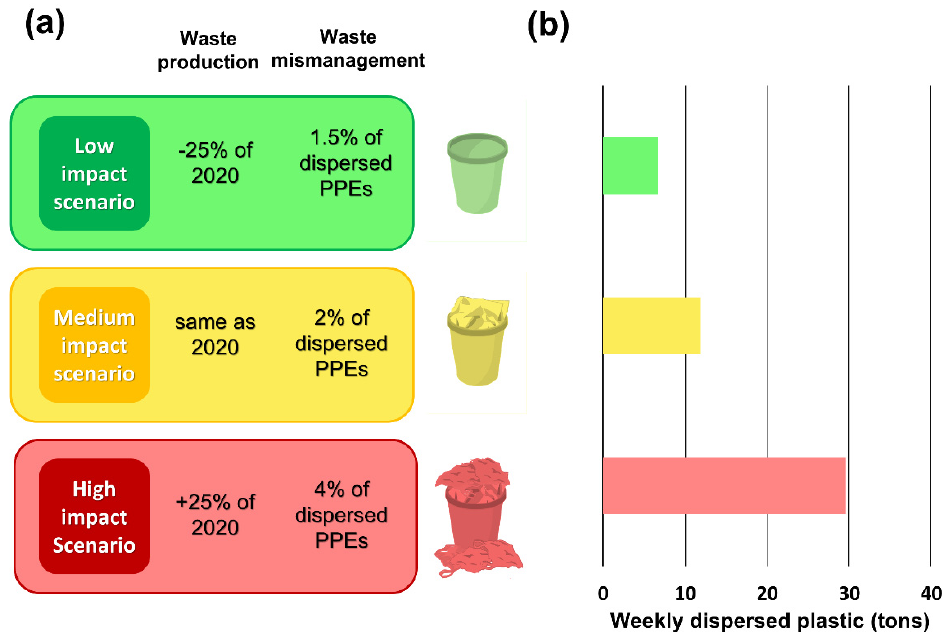
Figure 6. ( a ) Parameters used for the establishment of a future scenario (including an increasing, decreasing, or similar weekly amount of the 2020 average value and different rates of mismanaged waste [49]). ( b ) Estimated dispersed plastic waste from PPEs usage weekly in the different scenar- ios.